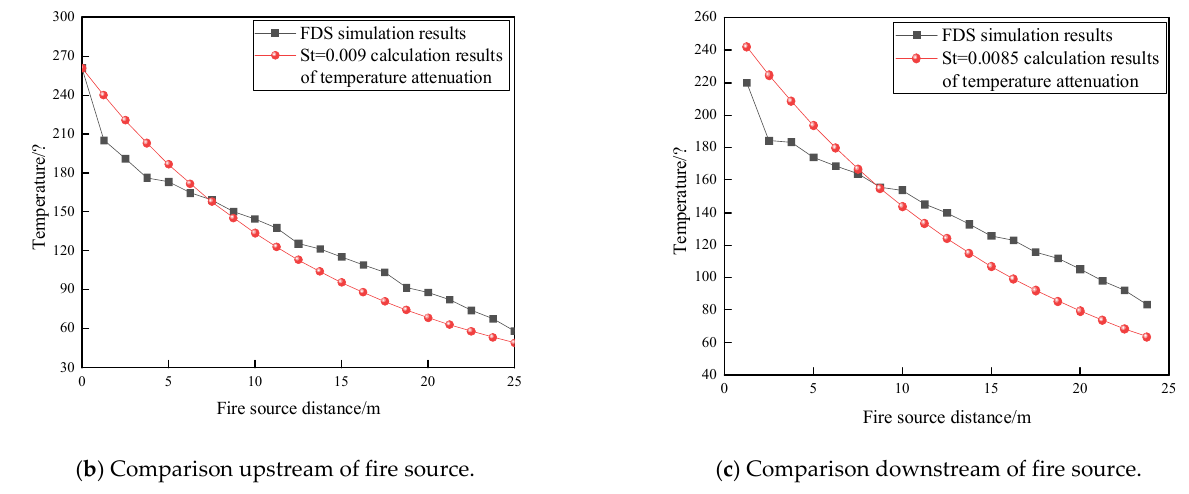
FDS simulation results St=0.009 calculation results